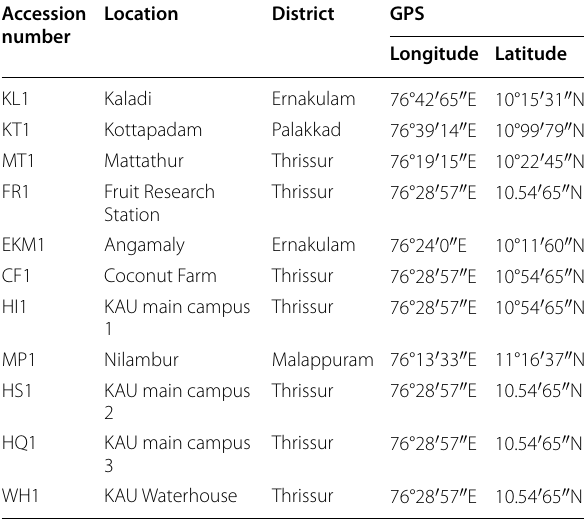
Table 1 Details of the isolates of Heterorhabditis spp.